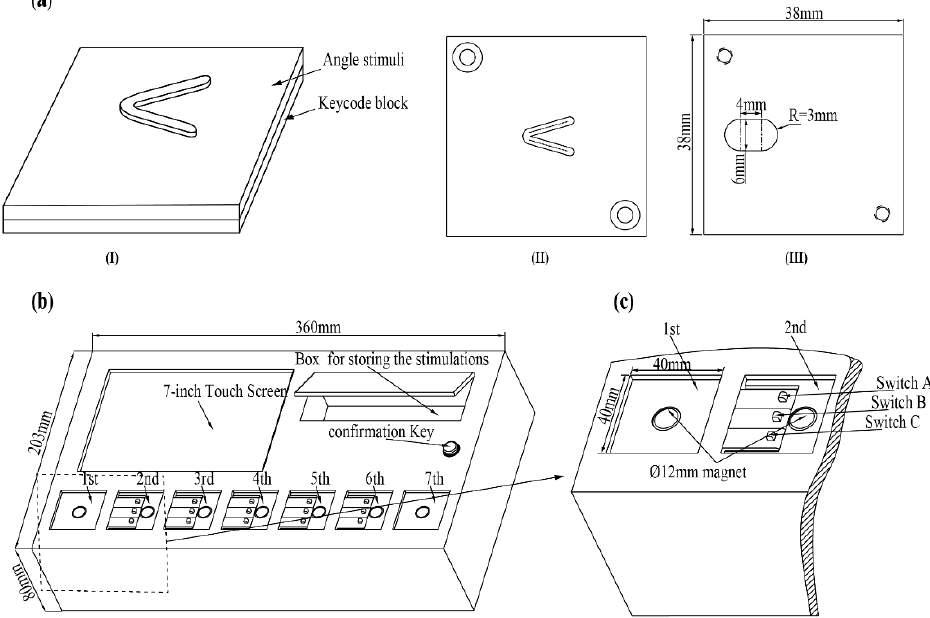
Figure 7. The configuration of the haptic angle sorting device: ( a ) design of the haptic pattern (I), which includes the angle stimulus at the front (II) and keycode base at the back (III); ( b ) interface design of the haptic angle device and ( c ) design of the haptic angle stimulus position in a fixed position and a sequence position.